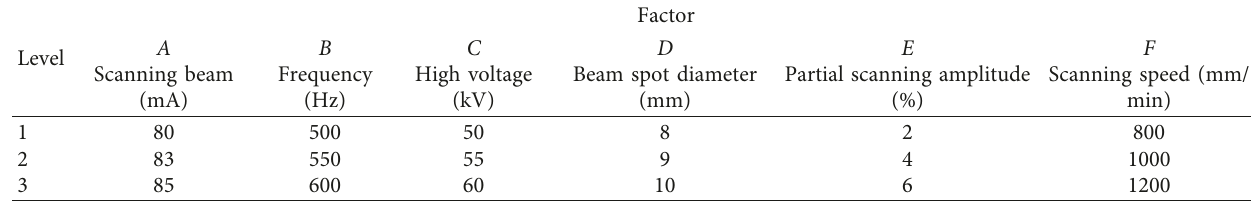
Table 2: Orthogonal experimental factor level.